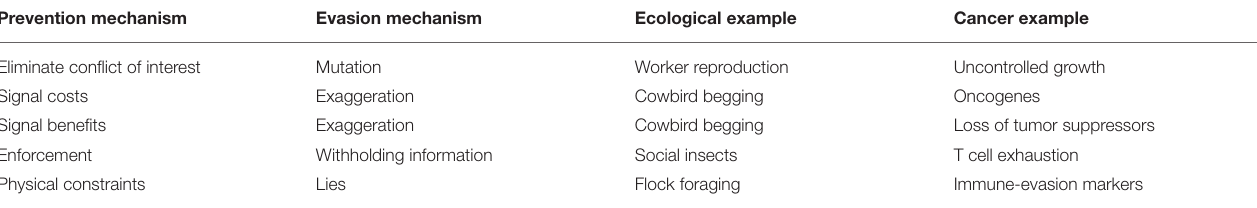
TABLE 3 | Mechanisms of evasion in ecology and